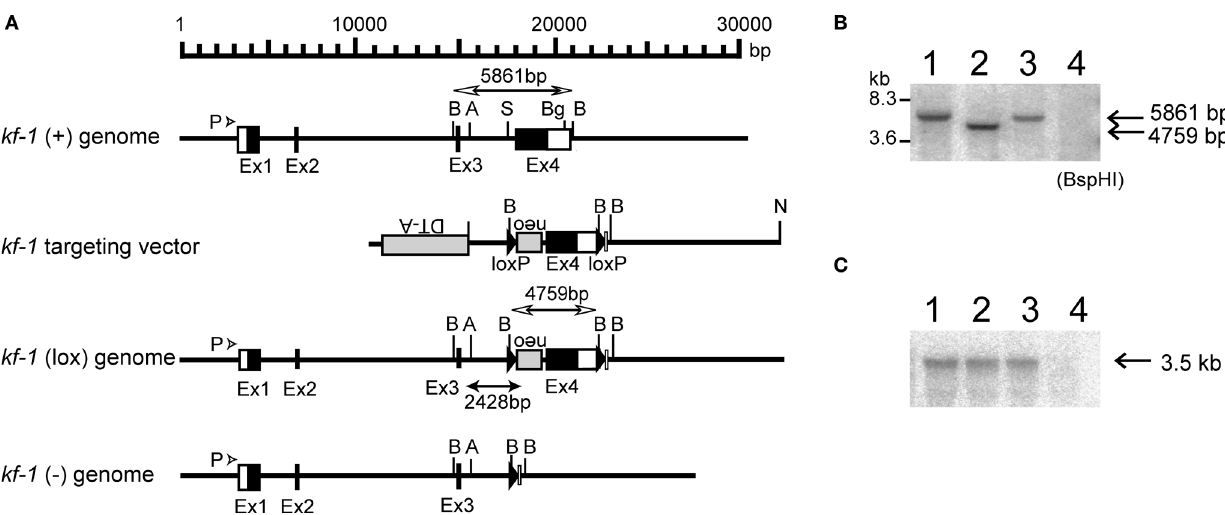
Figure 1 | Schematic presentation of the mouse kf-1 gene structure, targeting vector, and fl oxed and knockout alleles. (A) For construction of the target- ing vector, the diphtheria toxin A (DT-A) and neomycin resistance (neo) genes were inserted in reverse orientation at Ase I and Stu I sites at positions 15,600 and 17,515, respectively, and loxP cassettes were inserted using Stu I and Bgl II sites at positions 17,515 in In 3 and 20,081 in Ex 4, respectively. Closed and open boxes indicate the approximate positions of coding and non-coding exons, respectively. P with an arrowhead indicates the 49-bp promoter region identifi ed by the CAT assay (data not shown). Bsp HI restriction fragments, 5,861 and 4,759 bp in size, are indicated by open bidirectional-arrows above the kf-1 ( + ) and kf-1 (lox) genomes, respectively. The position corresponding to the 2,428-bp PCR product used to verify homologous recombination between the targeting vector and the kf-1 gene is shown below the kf-1 (lox) genome. Restriction sites for Ase I, Bsp HI, Bgl II, and Stu I were shown by A, B, Bg, and S, respectively. (B) Southern blot of Bsp HI-digested genomic DNA using the mouse kf-1 probe. The DNA bands indicated by arrows (5,861 and 4,759 bp) correspond to the Bsp HI-fragments shown in (A) . Lanes 1, 2, 3, and 4 are kf-1 + / + , kf-1 lox/lox , kf-1 + / − , and kf-1 − / − , respectively. Note that the intensity of the DNA band in lane 3 is half as intense as